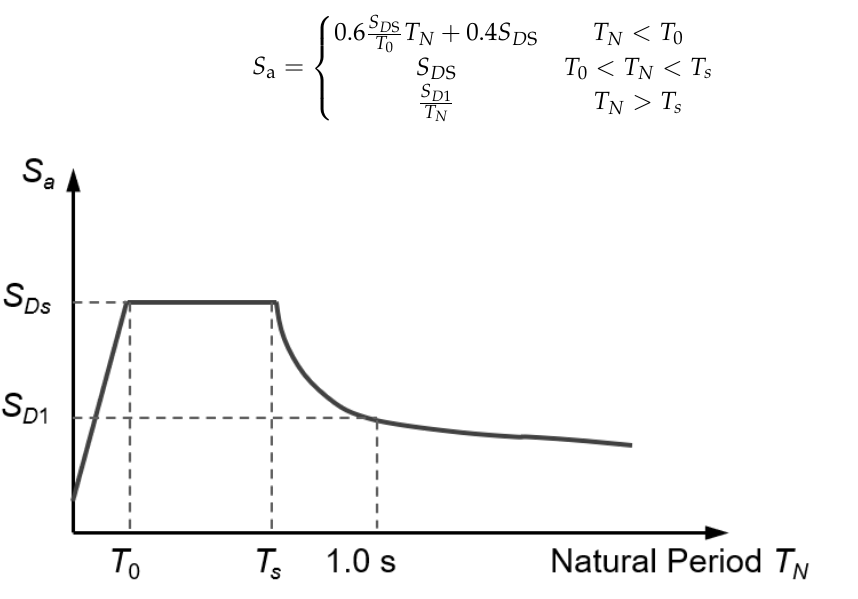
Figure 4. Response Figure 4. Response spectrum.